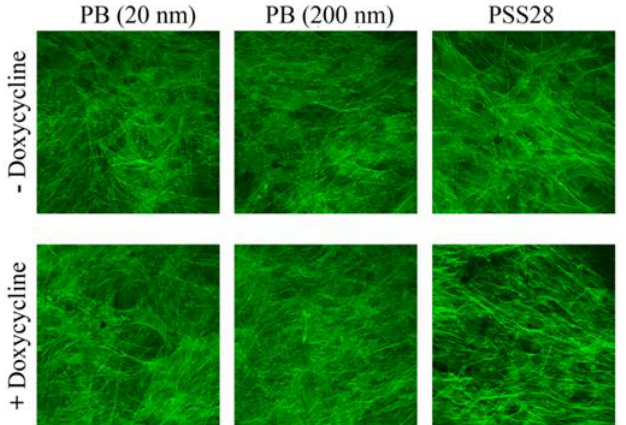
Figure 1. Confocal microscopy of C9 grown for four days on 20 nm thick polybutadiene (PB), on 200 nm thick PB, or on partially (28%) sulfonated polystyrene (PSS28) in the presence (+) or absence (−) of doxycycline and then fixed and labeled with AlexaFluor® 488-phalloidin to visualize f-actin.